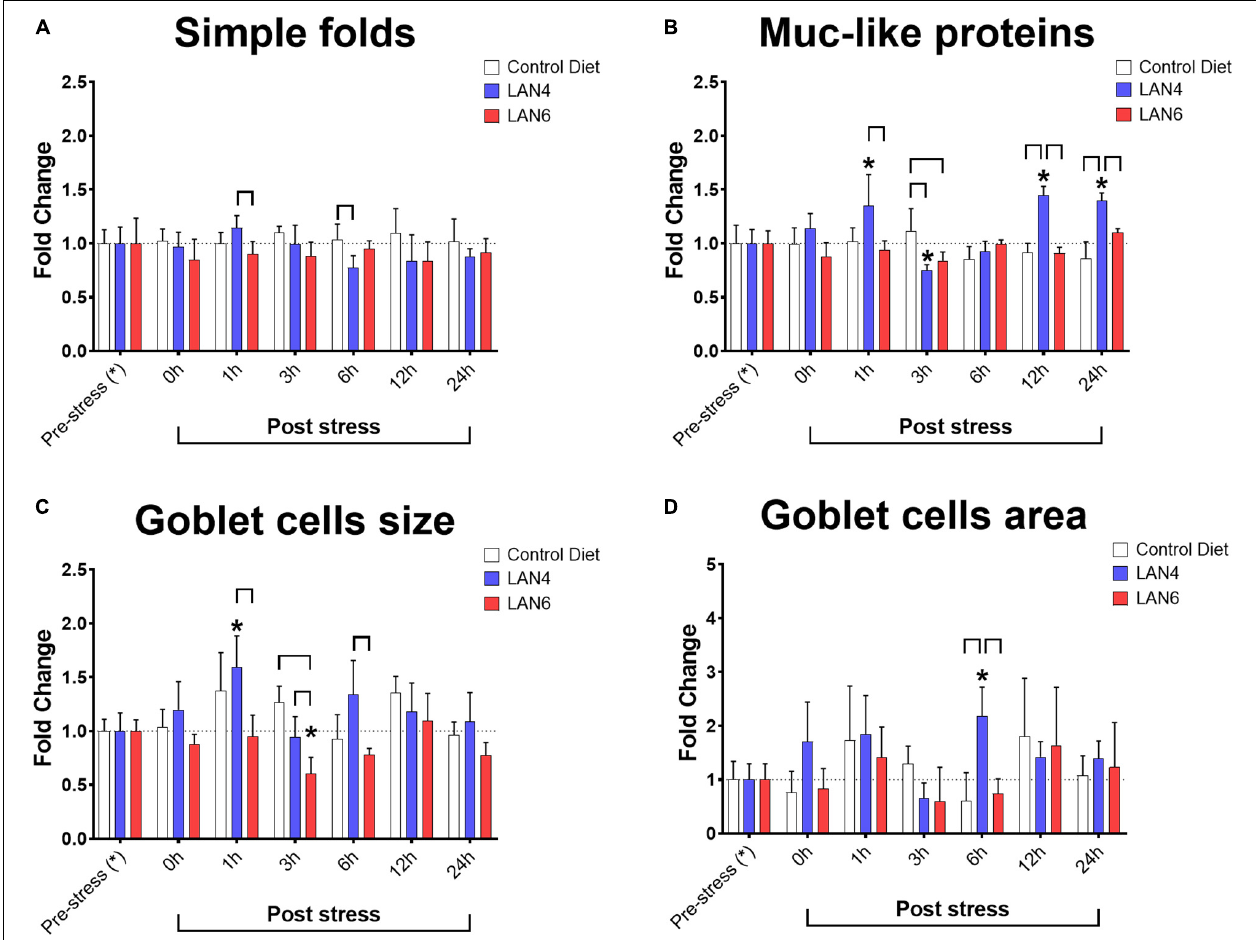
FIGURE 3 | Morphometric of PAS-stained tissue sections and detection of Muc-like proteins in the distal intestine from Atlantic salmon. Sampling times: pre-stress, 0 h (immediately after stress), 1, 3, 6, 12, and 24 h post-stress. In white: CD. In blue: LAN4. In red: LAN6. Each bar: n = 4. *: Significant differences ( p < 0.05) compared with pre-stress group (from each diet). Bracket: significant differences ( p < 0.05) between dietary groups at the same sampling time (CD, LAN4, and LAN6, respectively). (A) Simple folds. (B) Muc-like proteins. (C) Goblet cell size. (D) Goblet cell area. (A–D) Data are expressed as fold change related to the pre-stress group of each